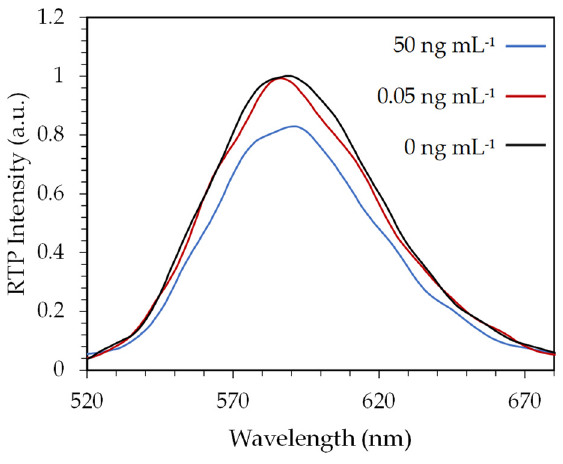
Figure 4. Phosphorescence emission signals registered after analysis of samples containing different AFM1 concentrations employing the indirect competitive immunoassay.